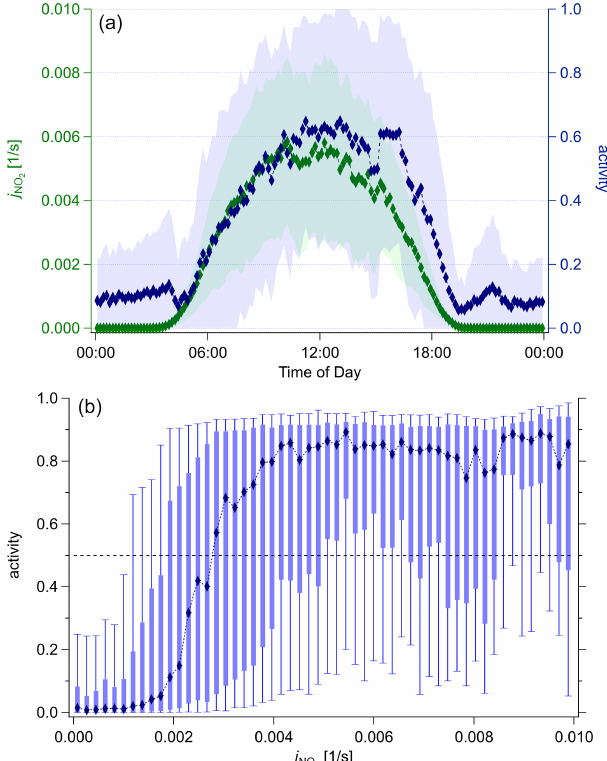
Figure 1. (a) Diel profile of photolysis frequency j NO activity η (blue) averaged for each minute interval. Time is in UTC. (b) Box–whisker plot of activity as a function of photolysis fre- quency. The markers and dotted line mark the median, boxes range from the 25% quantile to 75% quantile, the whiskers mark the 10% and 90% quantiles, respectively. The dashed black line marks the transition from passive to active regime η > 0 . 5. A clear nonlin- ear correlation is visible. Although the correlation is nonlinear, the Pearson correlation coefficient equals